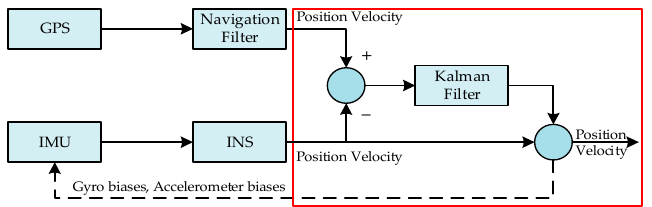
Figure 1. Architecture of the loosely coupled Global Positioning System (GPS)/Inertial Navigation System (INS) integrated system.